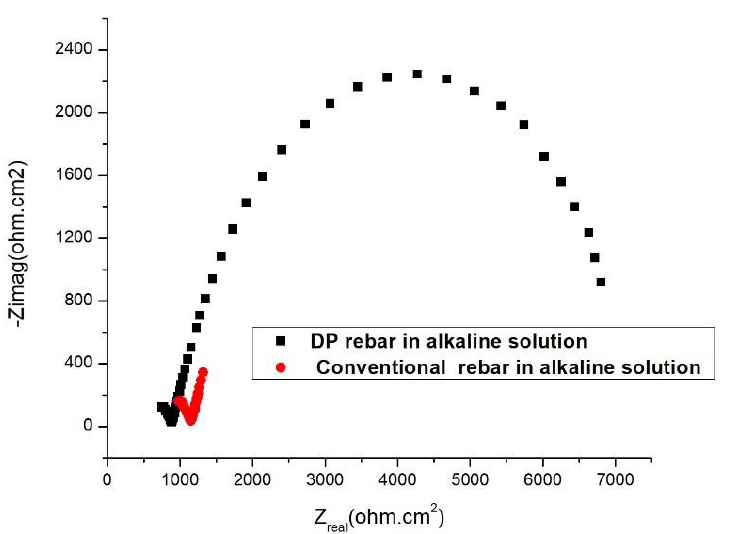
Figure 7. Electrochemical impedance spectroscopy (EIS) Nyquist curve in an alkaline solution (without Cl − ions). EIS, electrochemical impedance spectroscopy.